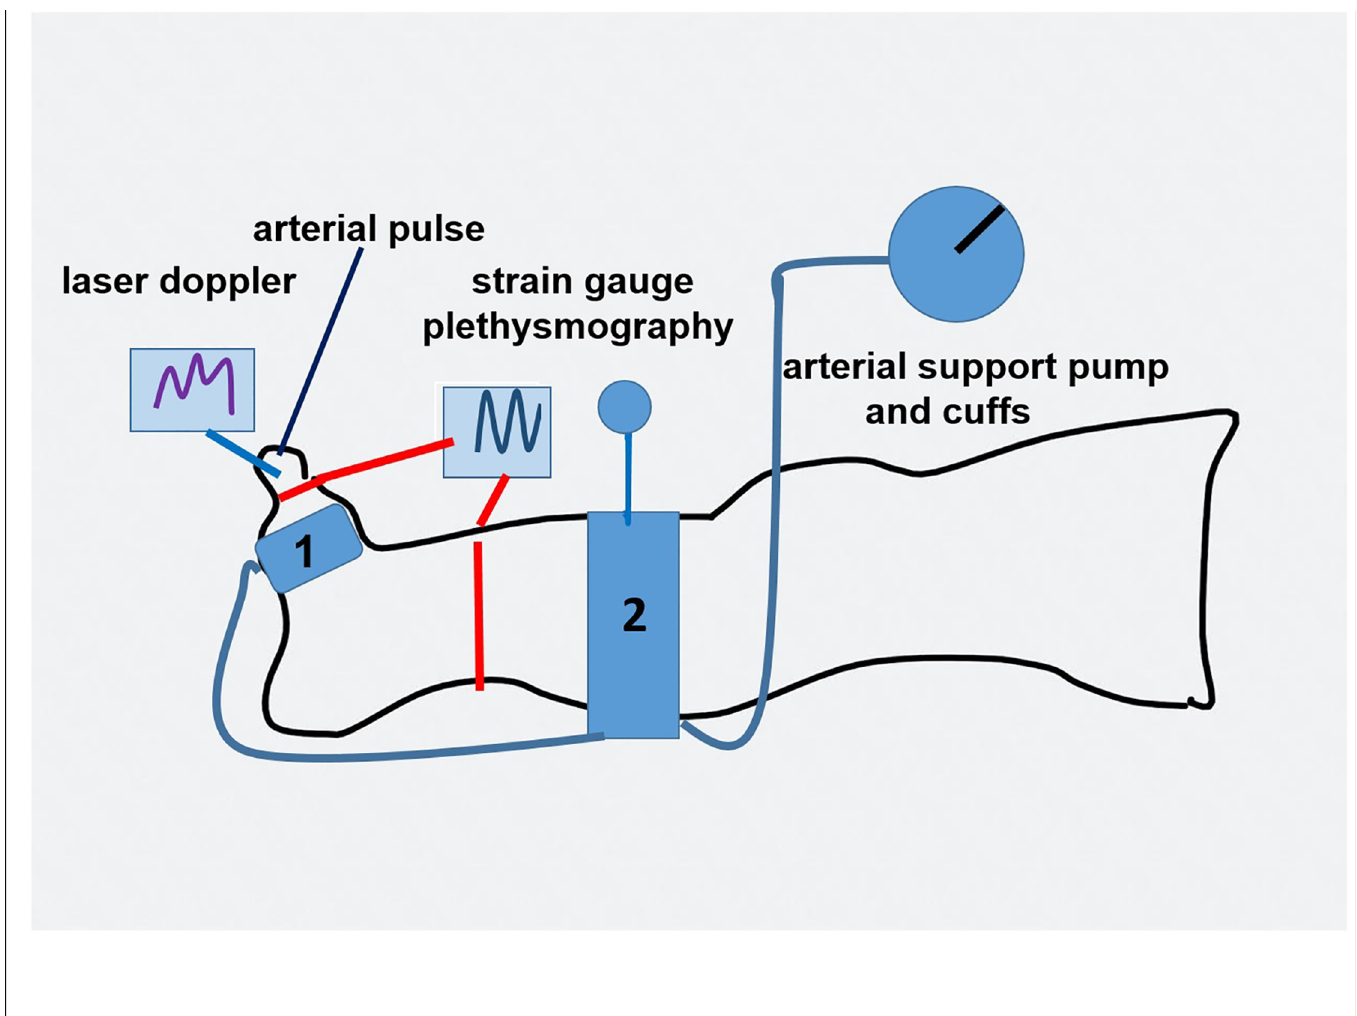
Fig 1. Sites for recording the toe skin capillary flow and arterial pulse, and arterial inflow into toe and calf. Numbers 1 and 2 depict arterial assist pump chambers.